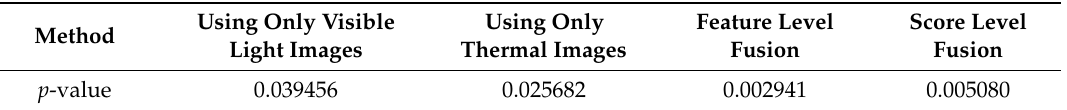
Table 12. The p -value of the performances of different system’s configurations using our proposed method and previous method